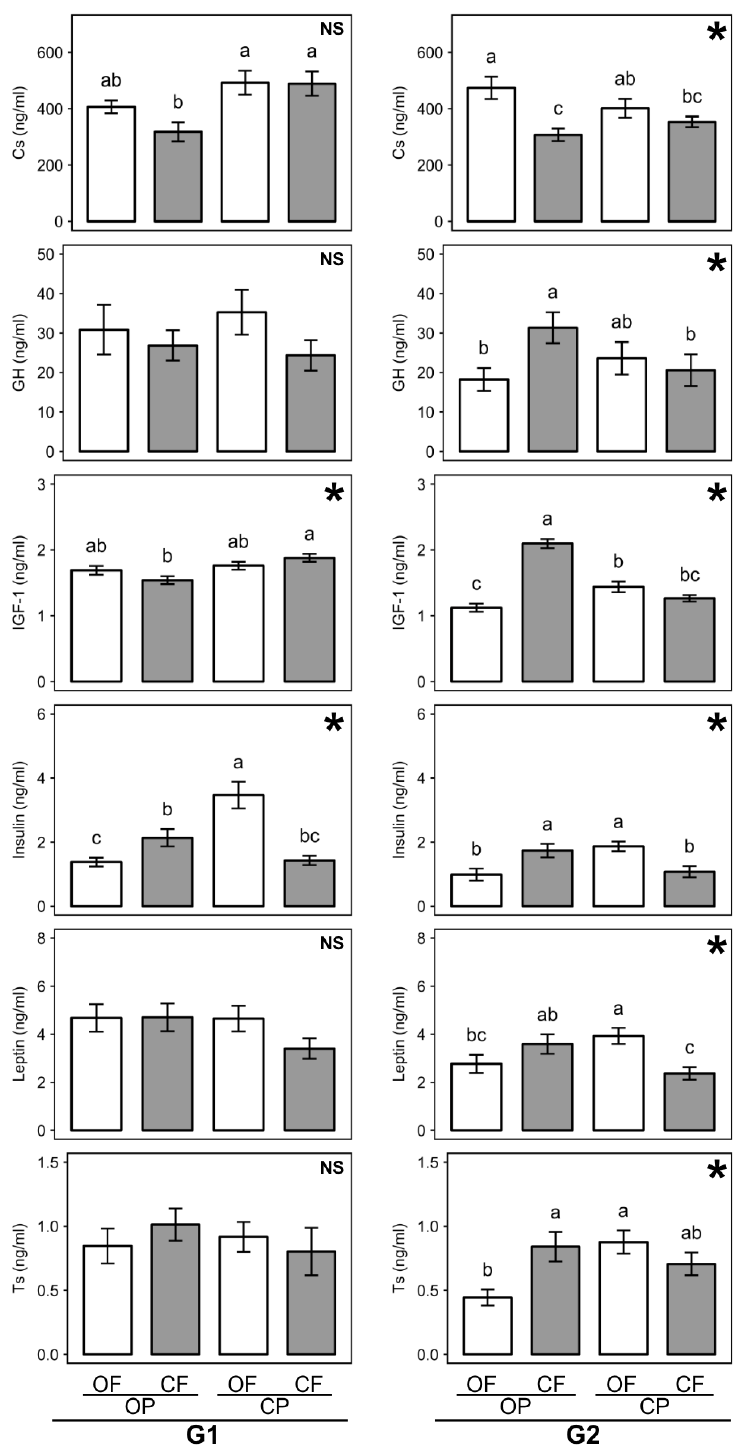
Figure 3. Effects of organic crop protection (OP) or conventional crop protection (CP) and organic fertility management (OF, white bars) or conventional fertility management (CF, shaded bars) on the plasma concentrations of corticosterone (Cs), growth hormone (GH), insulin-like growth factor 1 (IGF-1), insulin, leptin and testosterone (Ts) of the first ( G1 ) and second ( G2 ) generation of rats. ReScheme 24 animals, different letters above bars indicate significant difference ( p < 0.05) determined by Tukey’s HSD test. * two-factor ANOVA detected a significant interaction between crop protection and fertilization regimes (see Table S6).